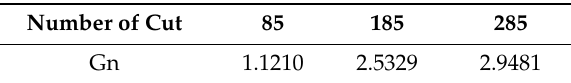
Table 3. Gn value of in the milling.